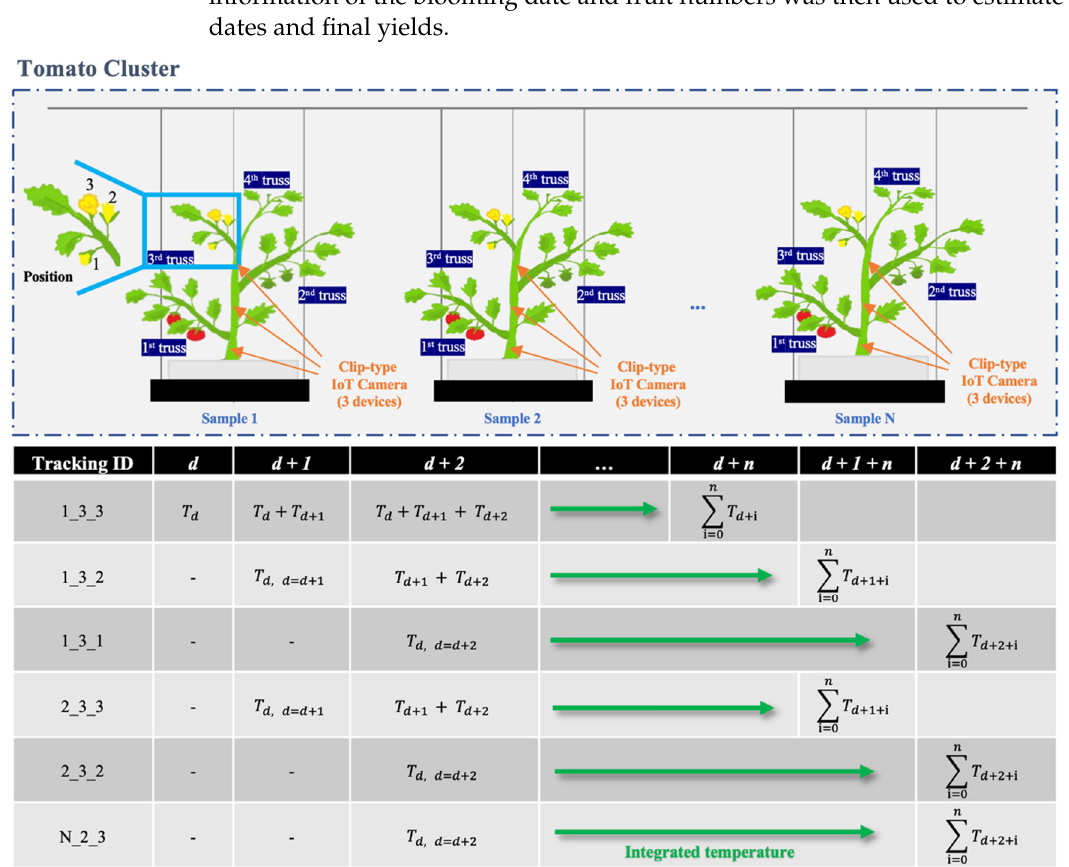
Figure 9. Tracking and harvest date estimation from integrated average daily temperature. Tracking ID format = Sample number_Truss number_Position number; T = Average of daily temperature (° Celsius); d = Date of flower opening; d + n = harvesting date at specific integrated average of daily temperature (e.g., ∑ 𝑇 (cid:3031)(cid:2878)(cid:2919) (cid:3041) (cid:2919)(cid:2880)(cid:2868) = 1100℃ ).